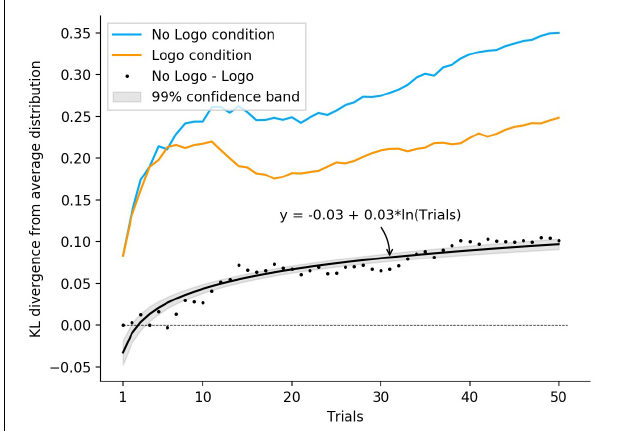
FIGURE 5 | Time course of the assimilation effect in Block 1. The upper lines depict the average Kullback-Leibler divergence for the Logo and No Logo conditions in Block 1, respectively, in orange and blue. Black dots represent the mean difference between the Logo and No Logo condition, with the black curve showing a fitted logarithmic regression model with its 99% confidence band. It is clearly visible that the average KL-divergence is at almost any point descriptively smaller in Logo condition compared to the No Logo condition. This suggests that participants’ predictions for the four agents in the Logo condition are less differentiated relative to the No Logo